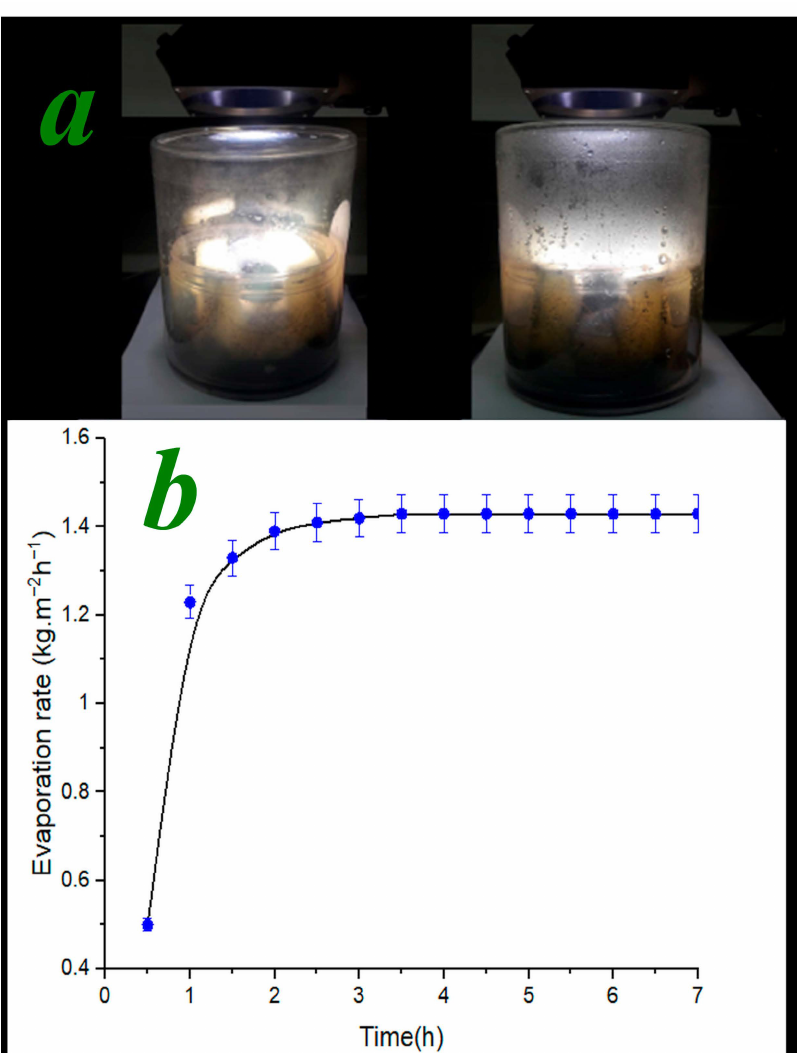
Figure 11. ( a ) Digital photos of the solar-driven interfacial desalination tests at the beginning of the experiment and after 30 min, respectively; ( b ) the average evaporation rate over a seven-hour experiment run in triplicate under 1-sun solar